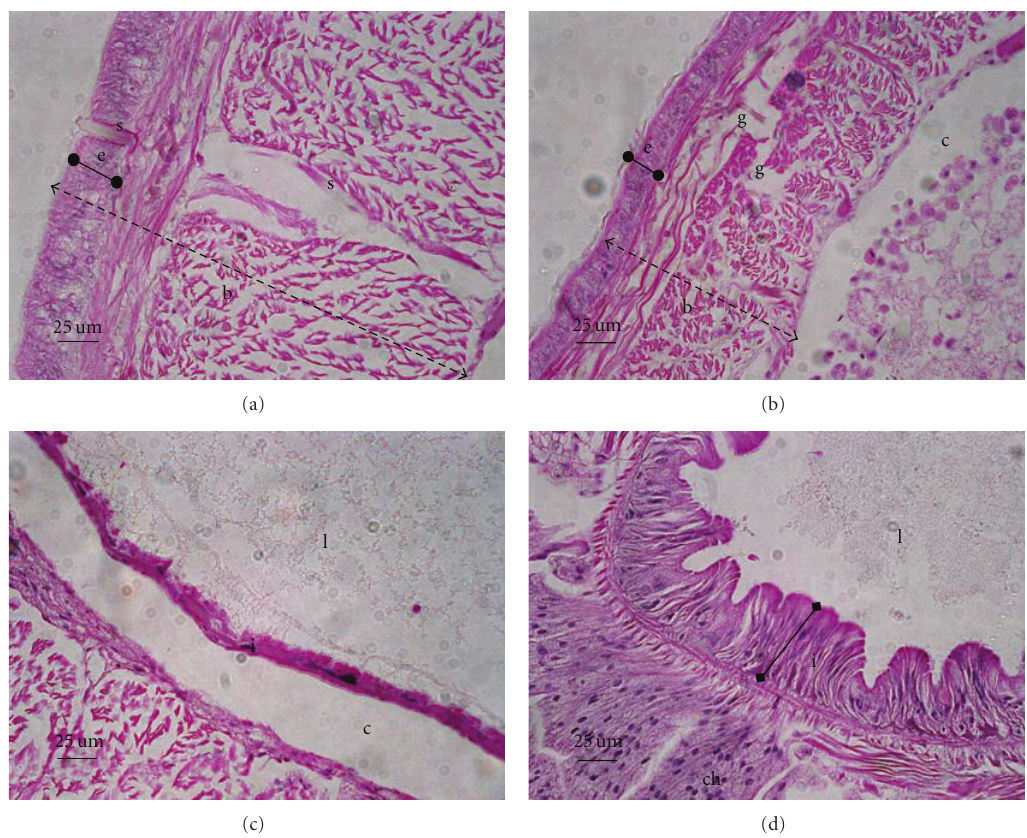
Figure 3: Histological changes in transverse sections of epidermis and body wall (a, b), and intestinal epithelium (c, d) in Pheretima peguana following a 48-h exposure to commercial neem extract (NEEM) containing 3.13 µ gcm − 2 Aza concentration on filter paper. (a) Negative control; intact muscles and epidermis. (b) Treated with NEEM showing expansion of spaces between the circular muscles and reduced epidermal and body wall thickness. (c) Control intestinal epithelium. (d) Treated with NEEM showing increased intestinal epithelial thickness. e: epidermis; b: body wall; i: intestinal epithelium; l: lumen; c: coelom; ch: chloragogenous tissue; g: gap between neighboring cells in circular and longitudinal muscles; s: setae. (Bar for each section is 25 µ